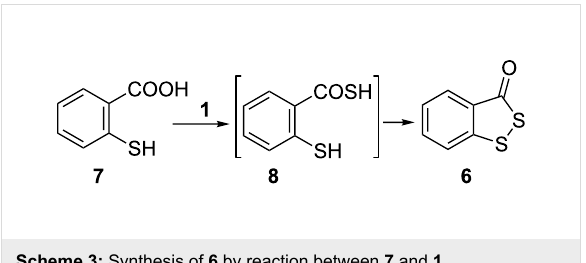
Scheme 3: Synthesis of 6 by reaction between 7 and 1